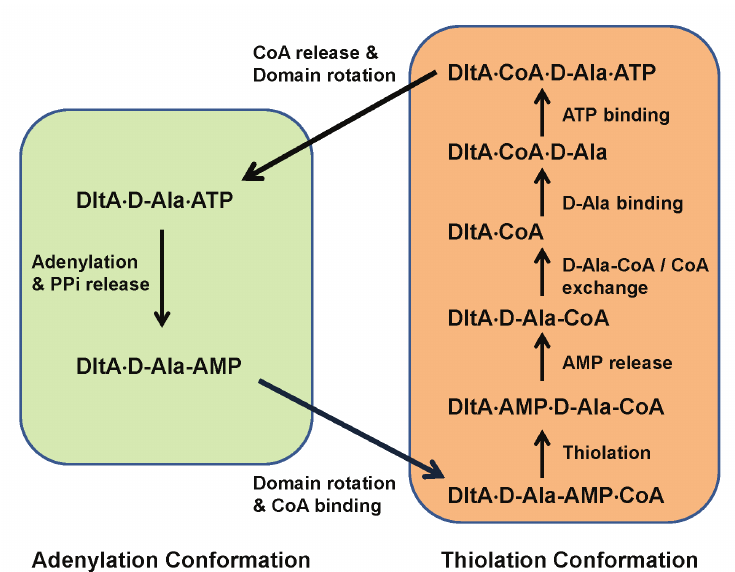
Figure 6. Hypothetical enzymatic cycle of DltA. Non-covalent DltA complexes are shown in text. Forward reaction, substrate binding and release steps are shown by arrows. Steps fulfilled by the adenylation conformation are shown in the green box, and those by the thiolation conformation in brown. The thioester between D-Ala and CoA (D-Ala-CoA) is the final product.